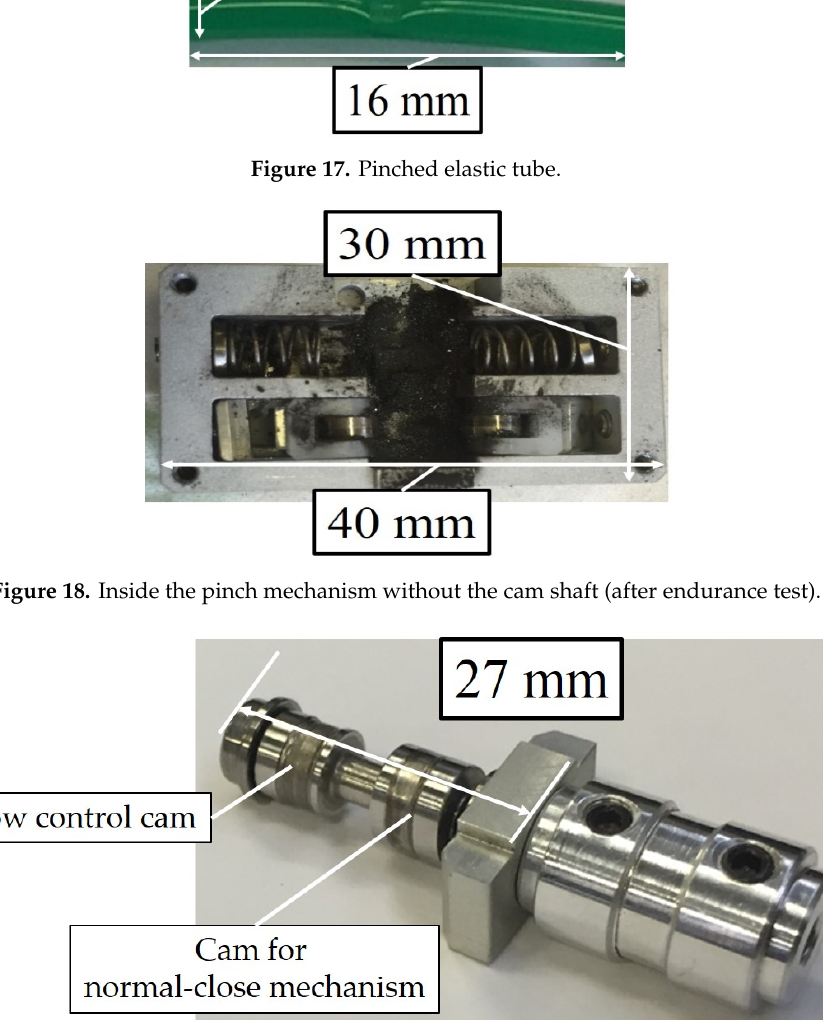
Figure 19. Worn cam shaft. Figure 19. Worn cam